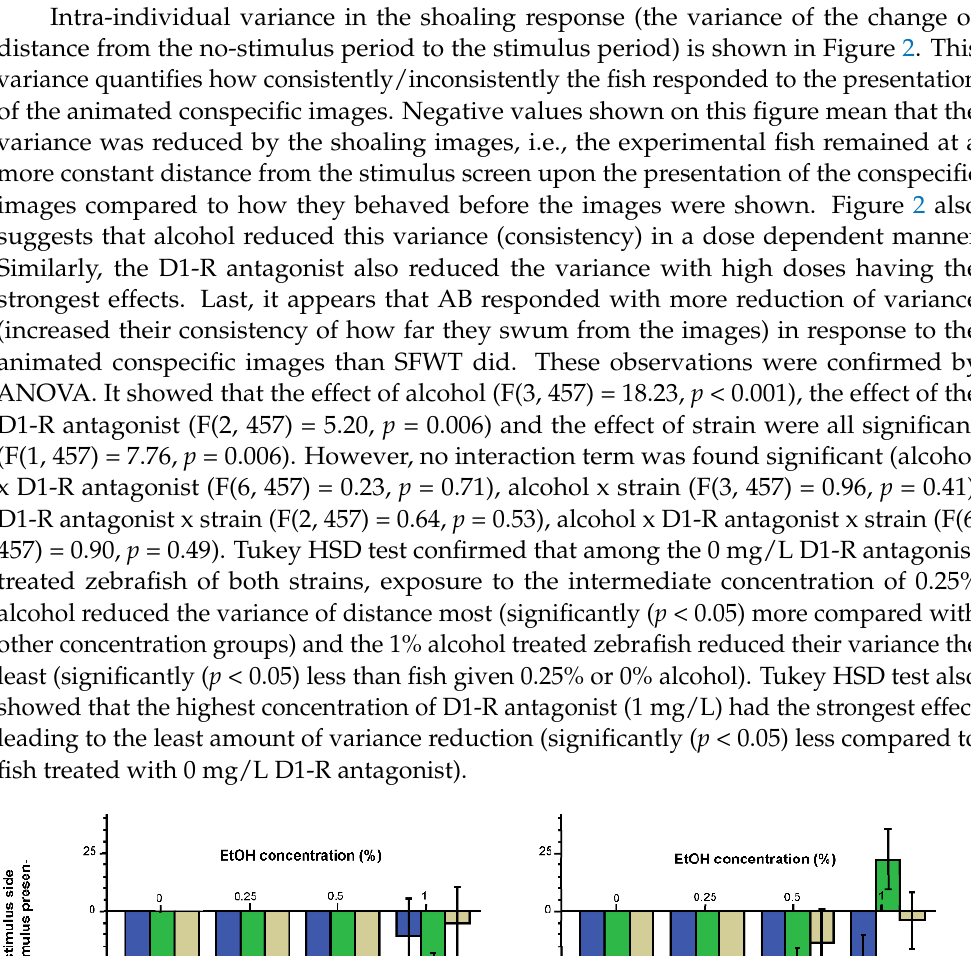
Figure 1. Change of distance to stimulus screen elicited by the presentation of animated conspecific images is influenced by the concentration of acute alcohol (X-axis) and the concentration of acute D1-R antagonist (legend) in an interactive manner. Mean ± S.E.M. are shown.